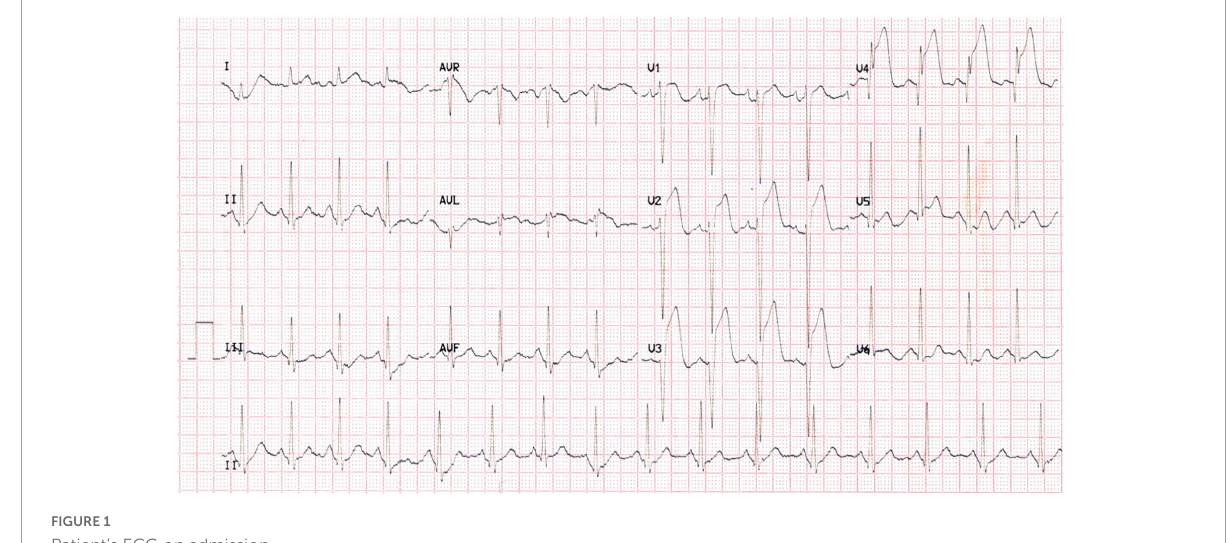
FIGURE1 Patient’s ECG on admission.